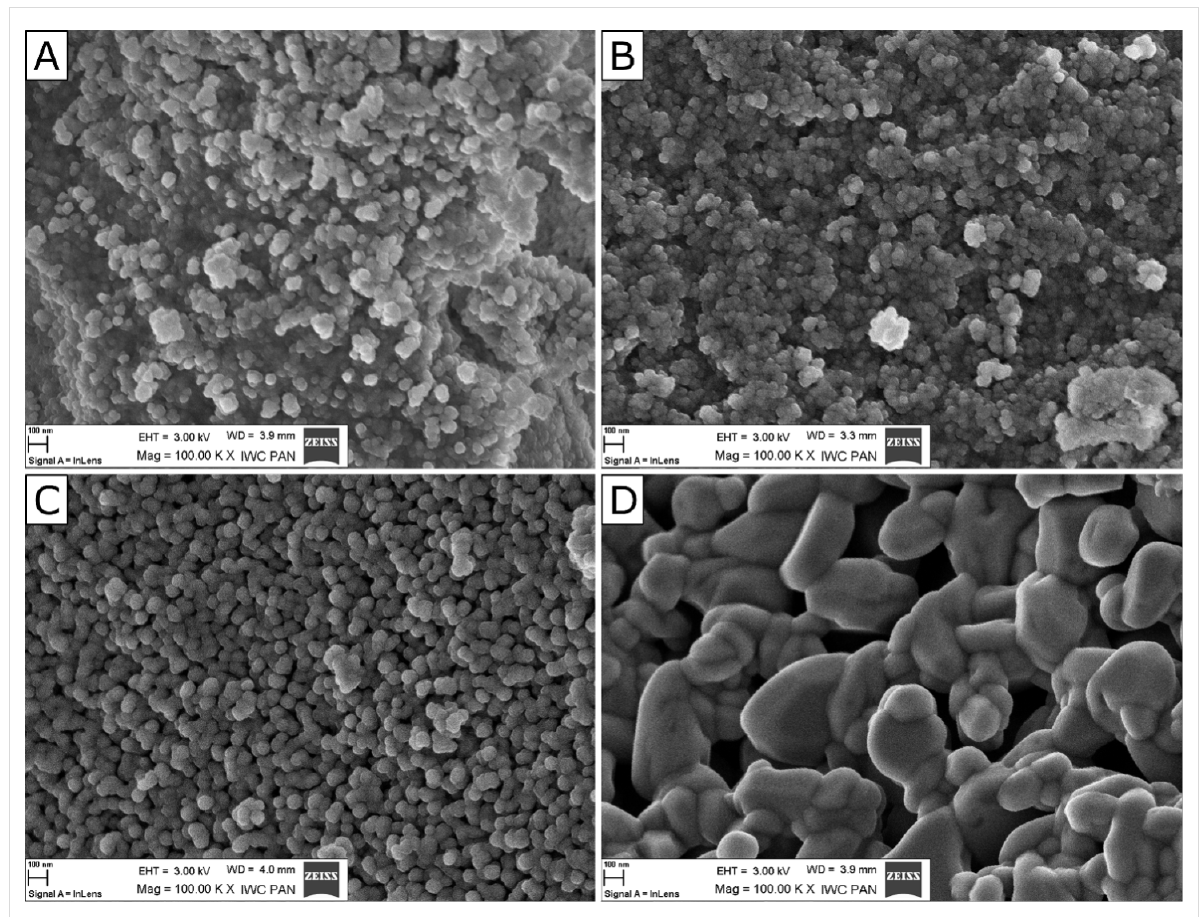
Figure 3: SEM images of four selected nano-ZrO 2 samples: (A) no annealing, and after annealing at (B) 500 °C, (C) 800 °C and (D) 1100 °C.